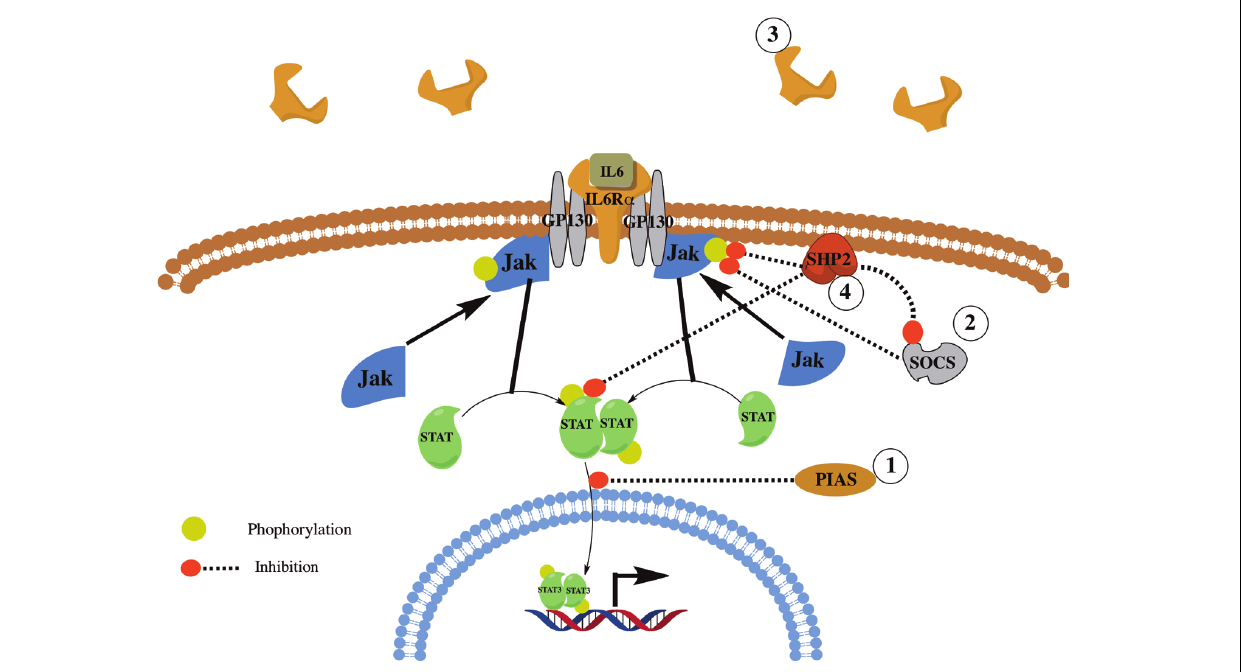
FIGURE 2 | Overview of IL6 signaling and regulation. Shown is a simplified overview of IL6 signaling and regulation. IL6 signals through its receptor, IL6 α R, and GP130.The signal is then transduced through JAK1/2 and STAT1/3